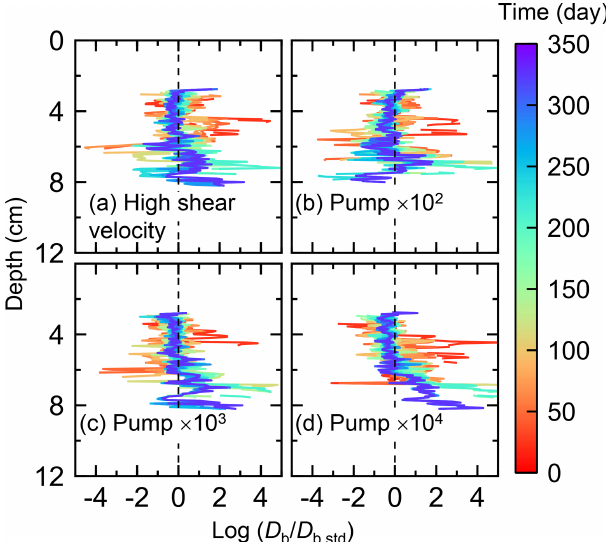
Figure E5. Time evolution of the biodiffusion coefficient ( D b ) in simulations (a) with 10 × higher shear velocity but otherwise default settings and (b–d) increasing water flows at the time of ingestion/egestion by factors of (b) 10 2 , (c) 10 3 , and (d) 10 4 but with otherwise default settings. Note that the ratios of D b values to those in default simulation ( D b , std in Fig. 7a) ( D b /D b , std ) are shown to facilitate comparison and dashed vertical lines are references to denote D b = D b , std